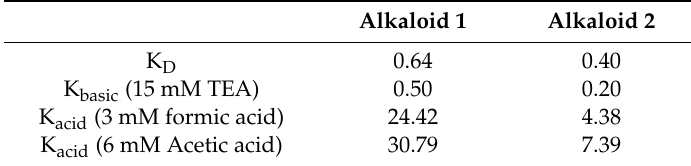
Table 3. Partition coe ffi cients of alkaloids 1 and 2 using pH-zone-refinement CPC with the solvent